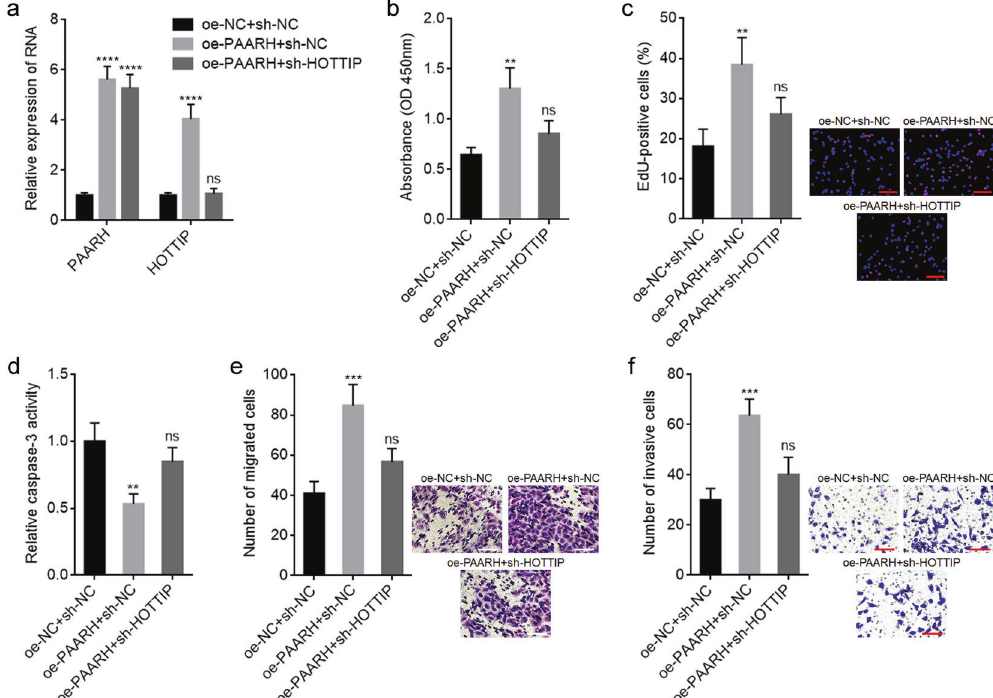
Fig. 6 Depletion of HOTTIP reversed the oncogenic roles of PAARH in HCC. a PAARH and HOTTIP expression in SNU-398 cells with PAARH overexpression and concurrent HOTTIP depletion. b Cell growth of SNU-398 cells with PAARH overexpression and HOTTIP depletion was detected using CCK-8 assays. c Cell growth of SNU-398 cells with PAARH overexpression and HOTTIP depletion was detected using EdU incorporation assays. Scale bars, 100 µm. d Cell apoptosis of SNU-398 cells with PAARH overexpression and HOTTIP depletion was detected using caspase-3 activity assays. e Cell migration of SNU-398 cells with PAARH overexpression and HOTTIP depletion was detected using transwell migration assays. Scale bars, 100 µm. f Cell invasion of SNU-398 cells with PAARH overexpression and HOTTIP depletion was detected using transwell invasion assays. Scale bars, 100 µm. Results are shown as mean ± SD based on three independent experiments. ** p < 0.01, *** p < 0.001, **** p < 0.0001, ns not signi fi cant, by one-way ANOVA followed by Dunnett ’ s multiple comparisons